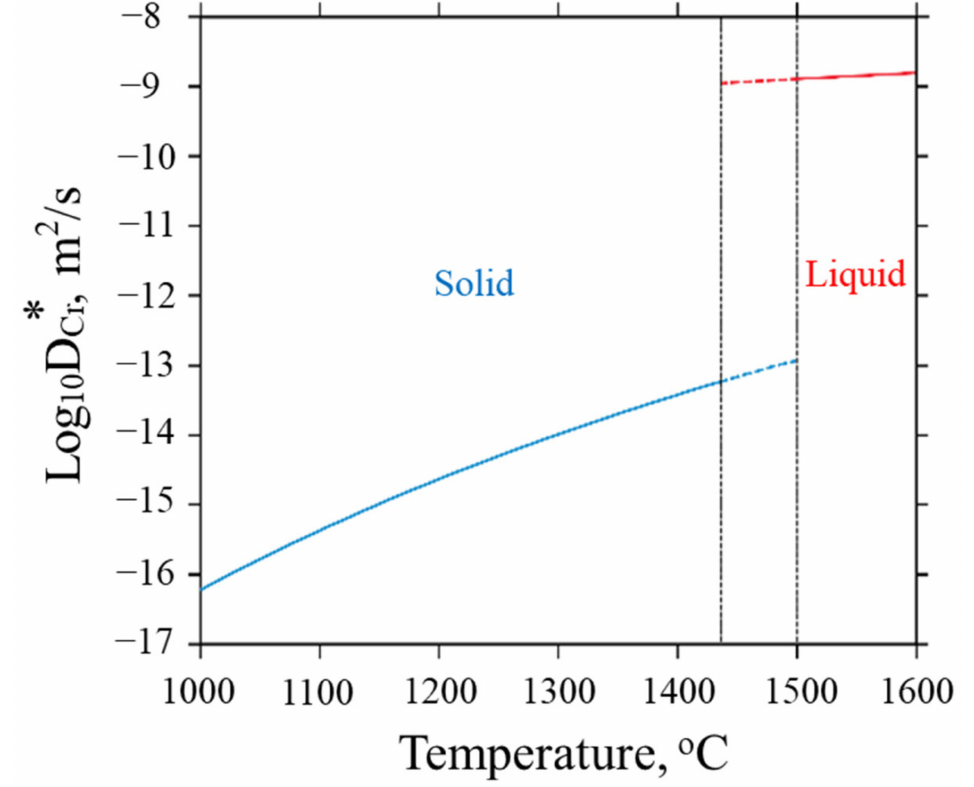
Figure 8. Calculated impurity diffusion coefficient of Cr in ZG45 steel (* means the impurity diffusion coefficient of Cr in both liquid and solid